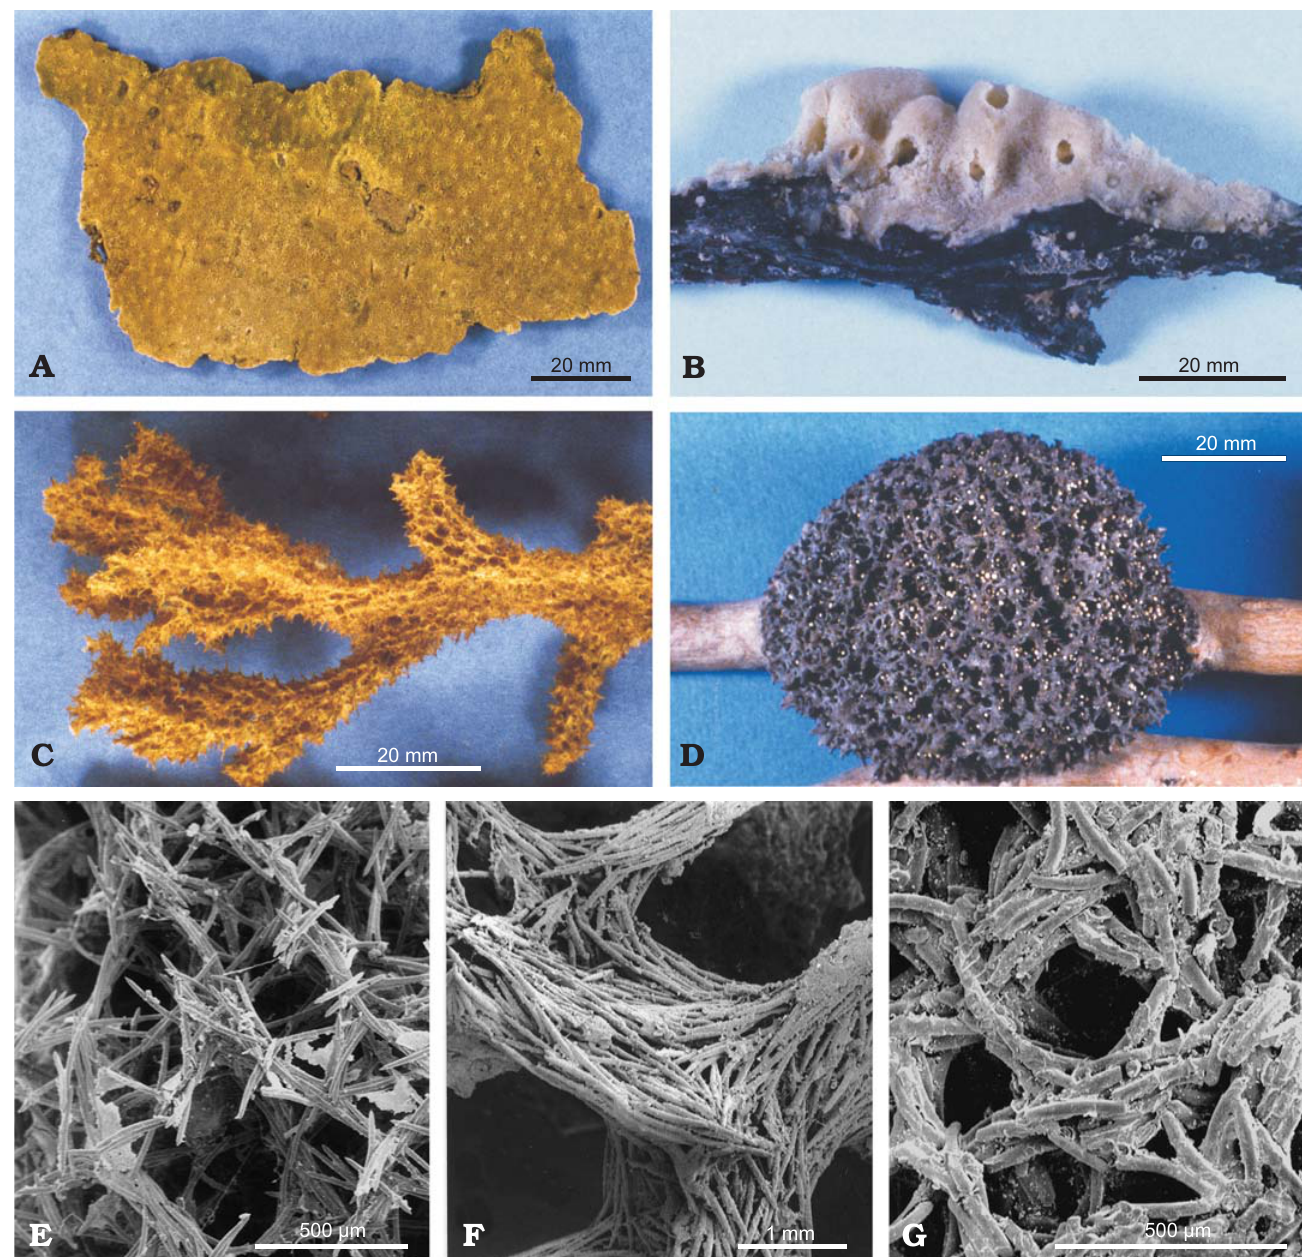
Fig. 1. Growth forms (A–D) and skeletal architecture with variable amount of spongin (E–G) of Recent freshwater sponges of the order Spongillida. A . Oncosclera jewelli (Volkmer-Ribeiro, 1963), Neotropical Region. B . Stratospongilla sp . C . Metania rhodesiana (Burton, 1938), Afrotropical Region. D . Drulia sp. E . Heterorotula capewelli (Bowerbank, 1863), Australasian Region. F . Drulia browni (Bowerbank, 1863), Neotropical Region. G . Uru gua- yella repens (Hinde, 1888), Neotropical Region. E–G SEM